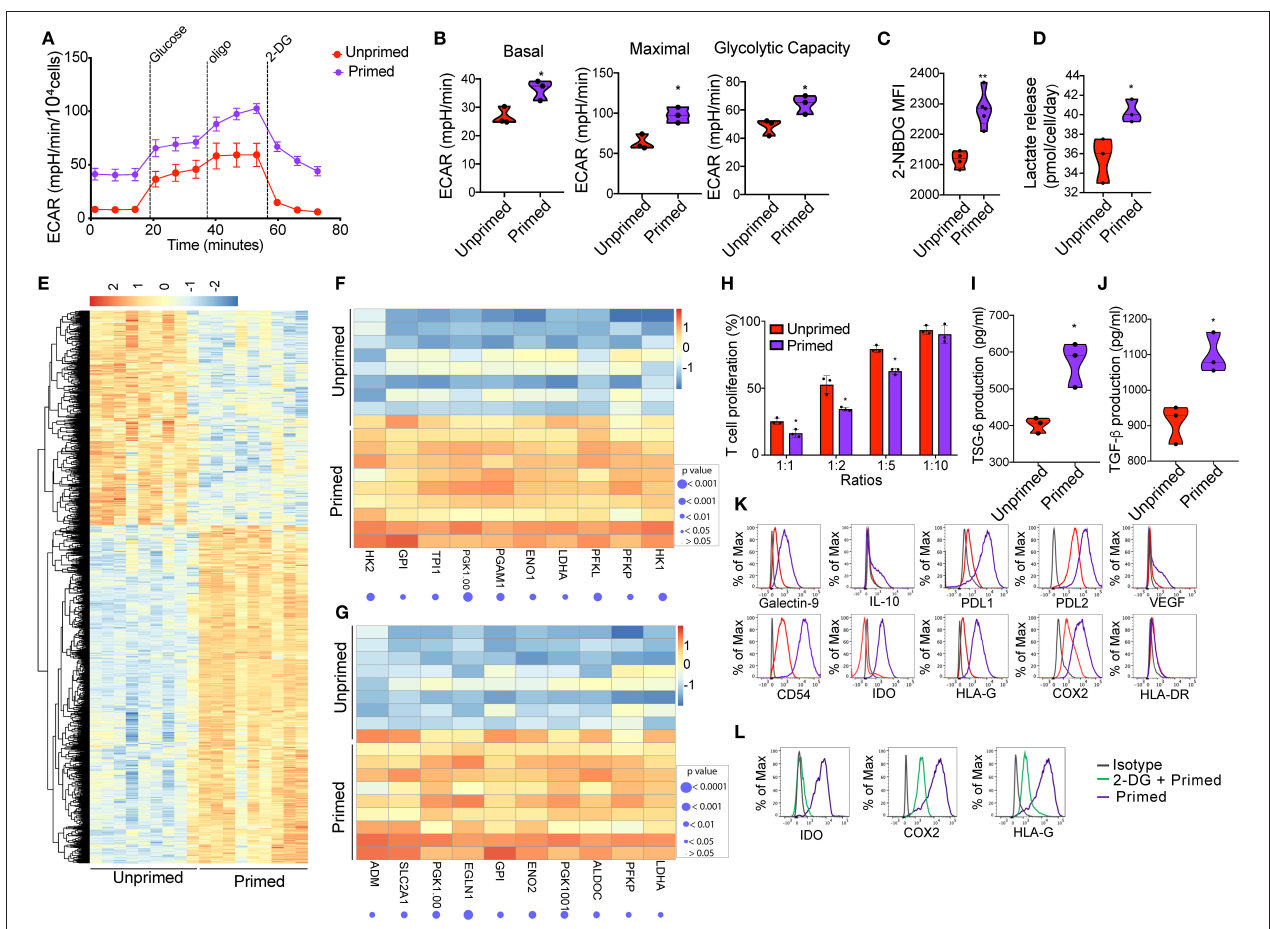
FIGURE 2 | Priming of CBti derived MSC induces metabolic reprogramming associated with an immunosuppressive phenotype. (A) A glycolytic activity as indicated by level of extracellular acidification rate (ECAR) was measured and calculated for primed MSCs (purple line) and control MSC (red lines) treated with 2 g/L D-glucose, 1 µ M oligomycin and 100mM 2-Deoxyglucose (2-DG). A representative graph is shown from three independent experiments. (B) Violin plots summarizing the ECAR data, basal ECAR (left panel), maximal ECAR (central panel) and glycolytic capacity (right panel) of primed MSCs (purple) and unprimed MSCs (28). Statistical significance is indicated as * p ≤ 0.05; bars represent mean values with standard error of mean. (C) Violin plots representing the uptake of glucose shown by 2-NBDG MFI by primed MSCs (purple) or unprimed MSC (red) (28). Statistical significance is indicated as ** p ≤ 0.01; bars represent mean values with standard error of mean. (D) Violin plots representing lactate release by primed MSCs (purple) or unprimed MSC (red) (28). Statistical significance is indicated as * p ≤ 0.05; bars represent mean values with standard error of mean. (E) Heatmap showing differential gene expression data of primed MSCs vs. unprimed MSC q < 0.05 and absolute log 2 fold change > 2, n = 9. (F) Heatmap showing genes of glycolysis pathway (from GSEA analysis) that are enriched in primed MSCs as compared to unprimed MSC. (G) Heatmap showing genes of hypoxia pathway that are enriched in primed MSCs as compared to unprimed MSC. (H) Bar graphs showing the percentage of T cell proliferation as compared to positive control after co-culture with primed MSCs (purple) vs. unprimed MSC (red) (28) at different ratios for 72h. n = 3. Statistical significance is indicated as * p ≤ 0.05; bars represent mean values with standard error of mean. Production of (I) TSG-6 and (J) TGF-b by primed MSCs (purple) vs. unprimed MSC (red) as measured by ELISA. n = 3 Statistical significance is indicated as * p ≤ 0.05; bars represent mean values with standard error of mean. (K) Representative histograms showing the expression of related immunosuppressive molecules on unprimed (red) and primed (purple) cord blood tissue derived MSC, compared to isotype control (gray) ( n = 4). (L) Representative histograms showing the expression of IDO (left), COX2 (central), and HLA-G (30) on primed cord tissue derived MSCs pretreated with 2-DG (green line) or untreated (purple), compared with the isotype (gray line). ( n =